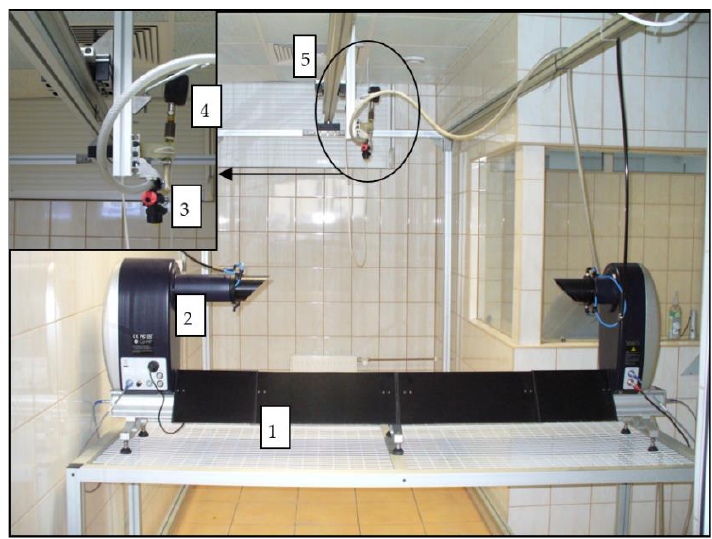
Figure 3. Measurement stand to the analysis of droplet size: 1—laboratory table, 2—particle spectrum analyzer, 3—nozzle body, 4—manometer, 5—guideway.